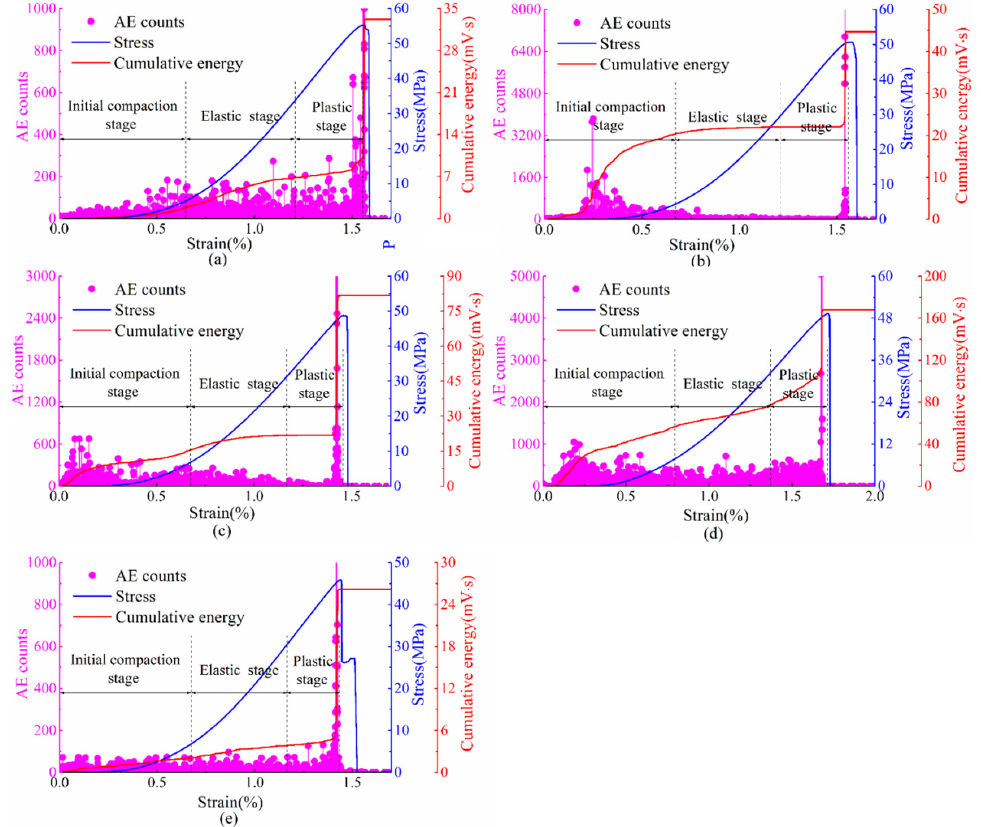
Figure 7. Stress ‐ strain curves, AE ringing count, and cumulative energy diagrams of yellow sandstone under different loading rates: ( a ) 0.9 kN/s; ( b ) 0.7 kN/s; ( c ) 0.5 kN/s; ( d ) 0.3 kN/s; and ( e ) 0.1 kN/s.